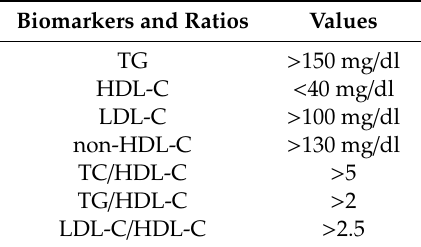
Figure 1. Overview of the potential role of excess visceral adiposity contributing to increased Atherogenic dyslipidemia risk. This figure illustrates the hypothesis that an uninterrupted positive energy imbalance over time can convert perfectly functional subcutaneous tissue cells into a generation of new fat cells (hyperplasia), allowing the storage of energy surplus. Over time, this adipose tissue becomes dysfunctional due to the subcutaneous Adipose tissue’s incapacity to expand and therefore saturate it. Under such circumstances, altered secretion of adipokines inflammatory cytokines occurs, among which we highlight: Leptin, Resistin, RBP4, Lipocalin2, ANGPLT2, TNF, IL-6, IL18, CCL2. This state of inflammation is maintained, increasing the ratios of dyslipidemic atherogenesis and causing harmful cardiometabolic consequences.